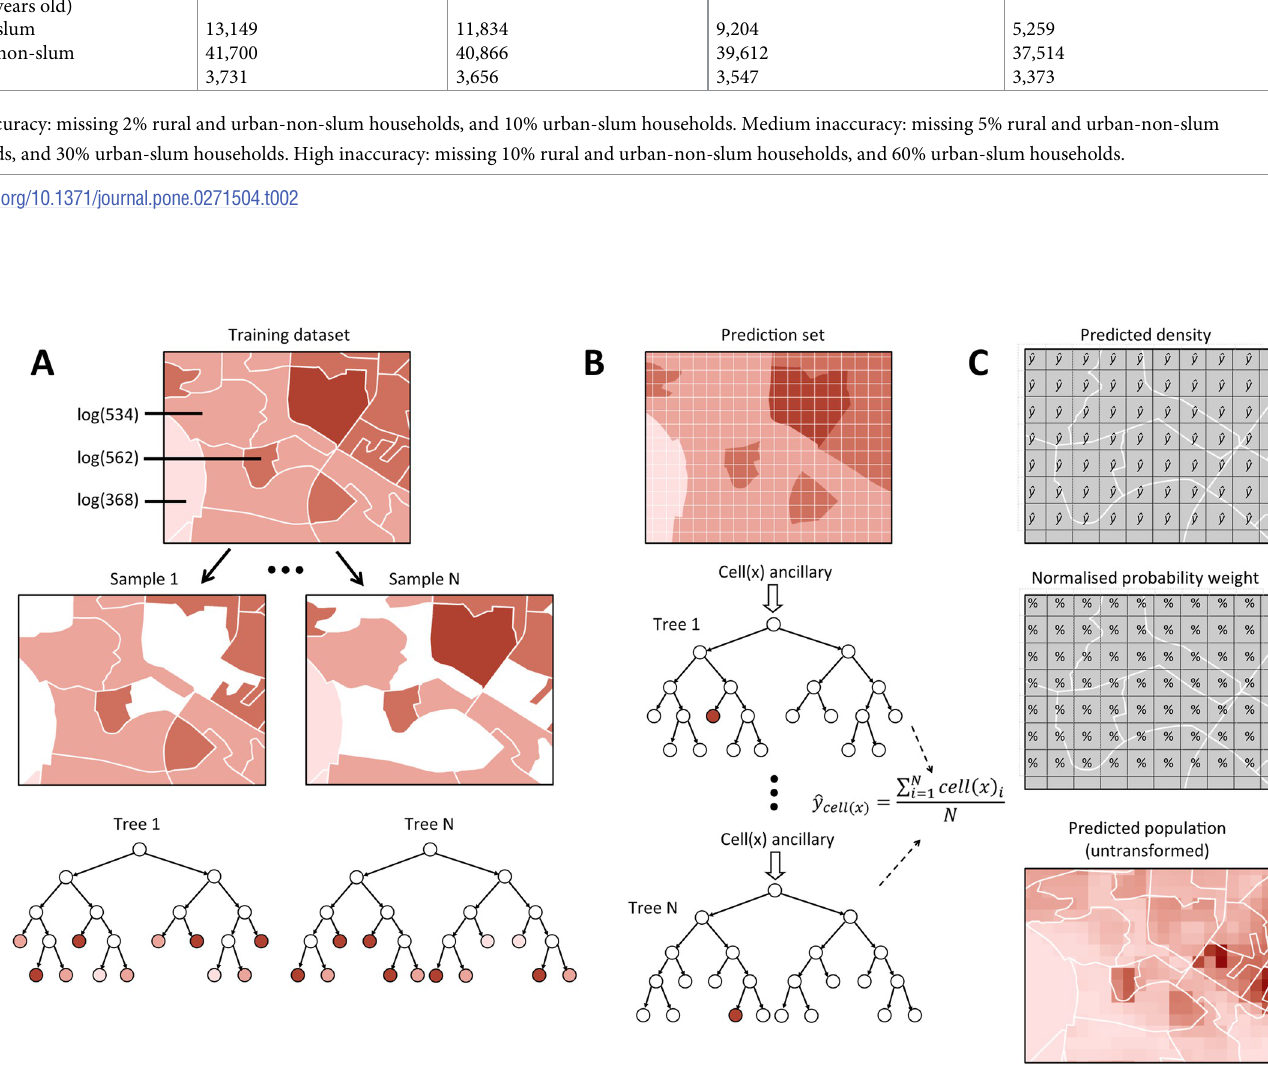
PLOS ONE | https://doi.org/10.1371/journal.pone.0271504 July 21,